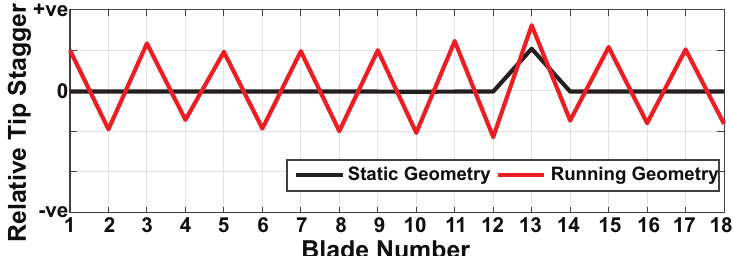
Figure 1. Typical alternate passage divergence (APD) behaviour illustrated through relative tip stagger pattern.